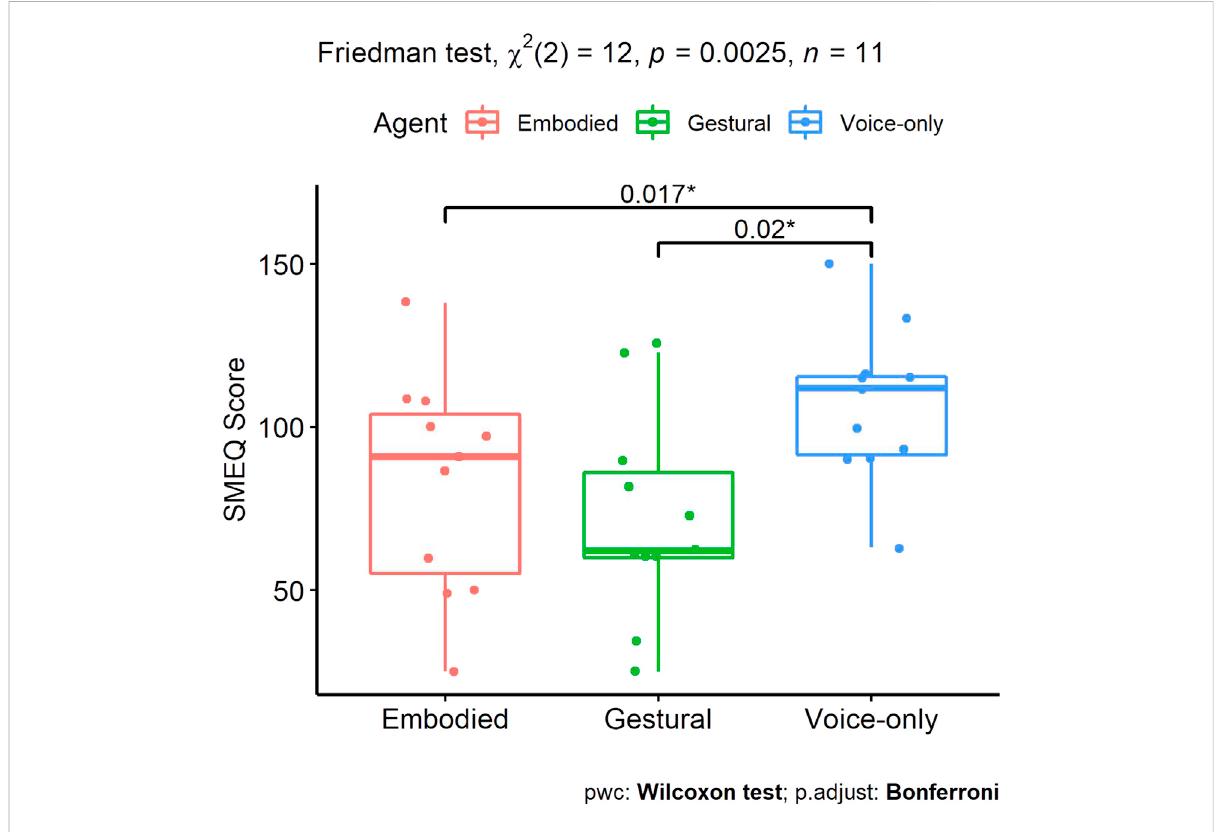
FIGURE 8 Results of the SMEQ (Statistical signi fi cance: *( p <